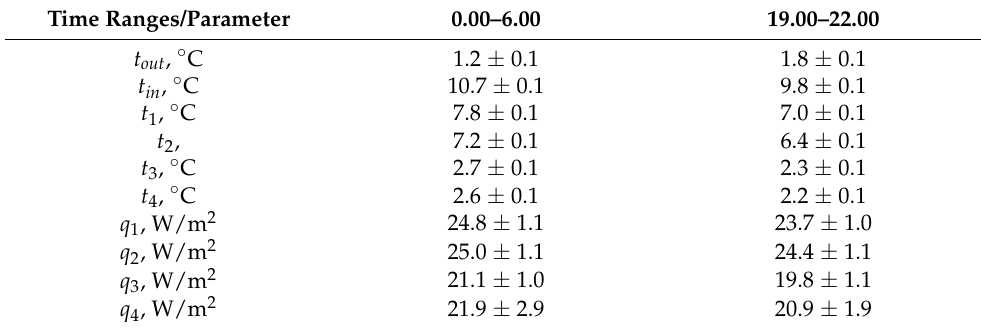
Table 1. Average values of thermophysical parameters of a single-chamber window for two different time periods on 21 February 2015. Time Ranges/Parameter 0.00–6.00 19.00–22.00 t out , ◦